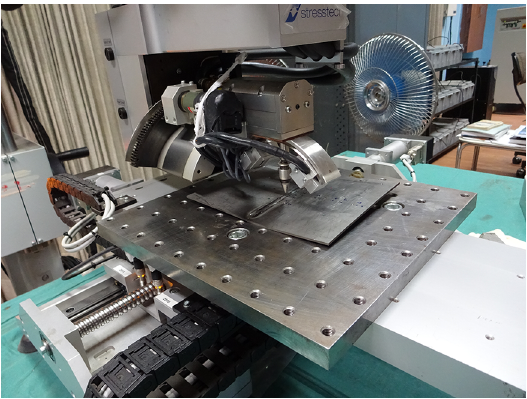
maximum principal stress and orientation of principle stress